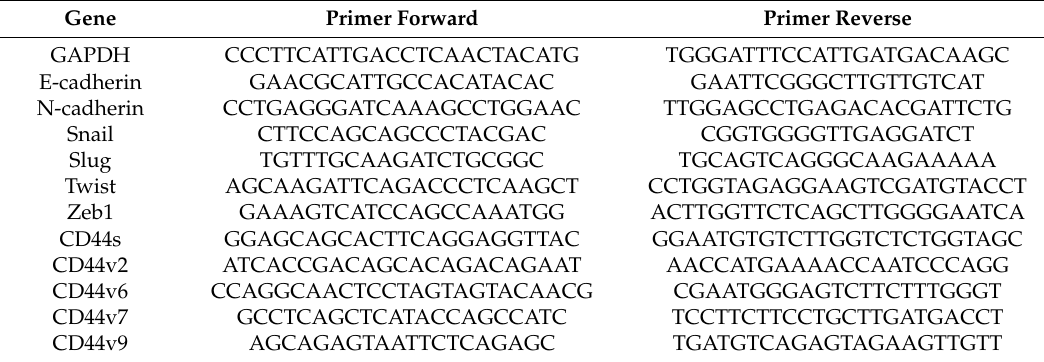
Table 1. List of primer used for gene expression